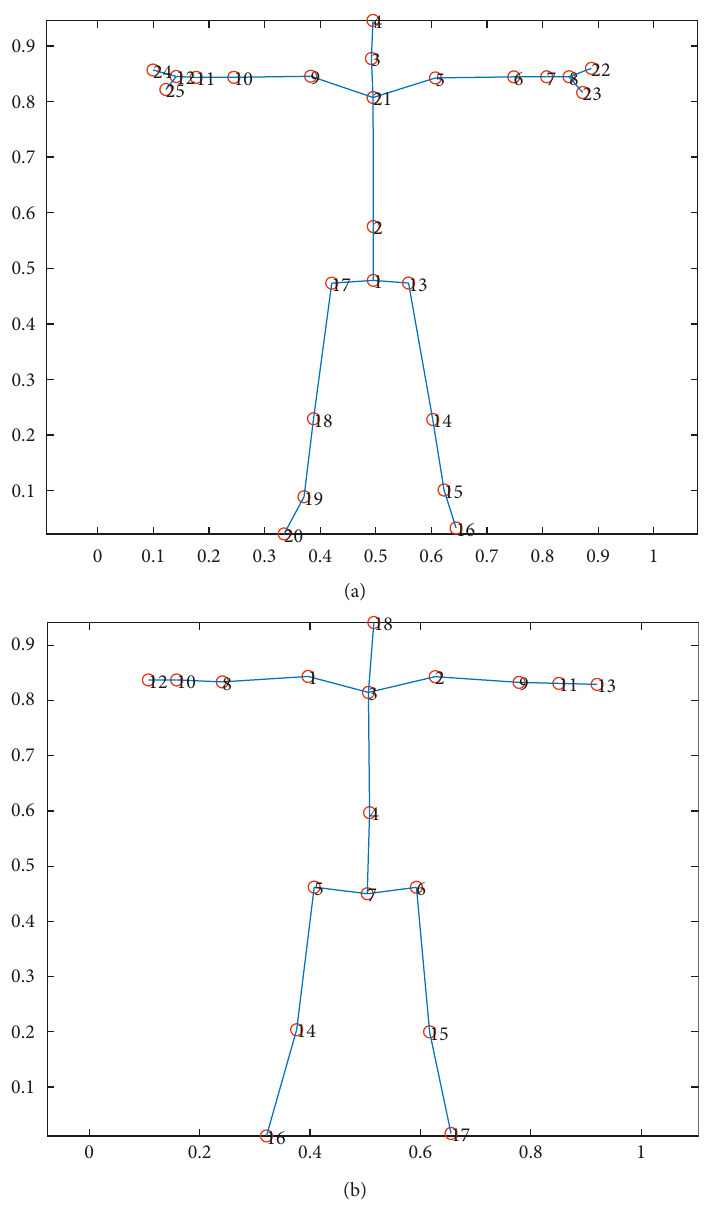
Figure 7: Schematic diagram of the joints of the two data sets. (a) NTU-RGB+D. (b) MSR Action